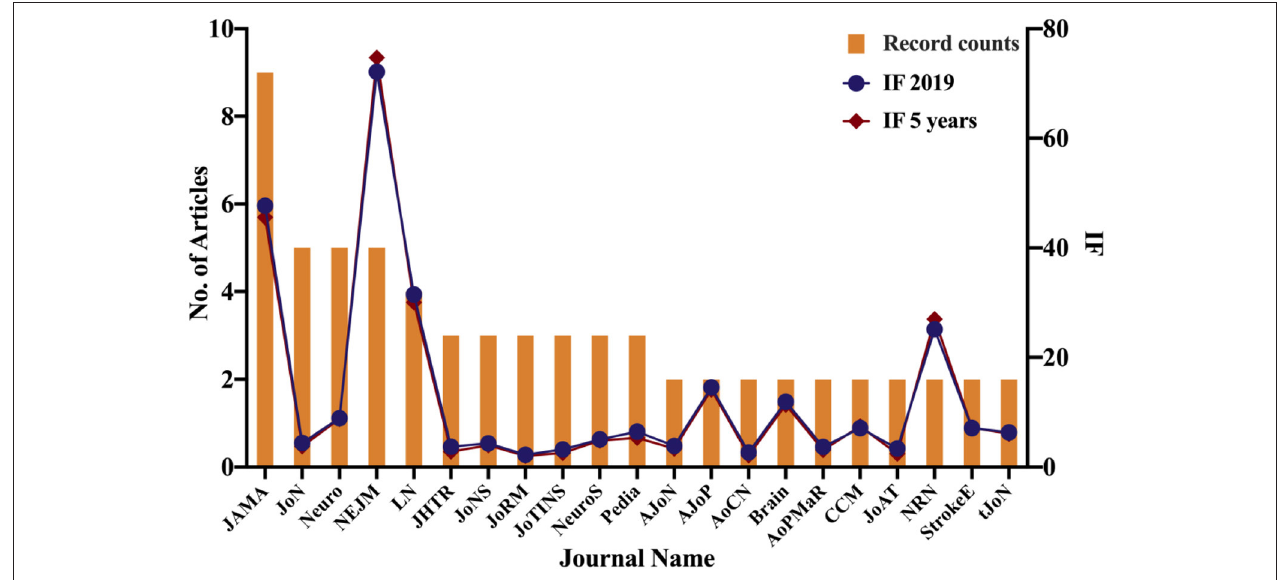
FIGURE 4 | Journals with more than 2 top-100 cited articles.